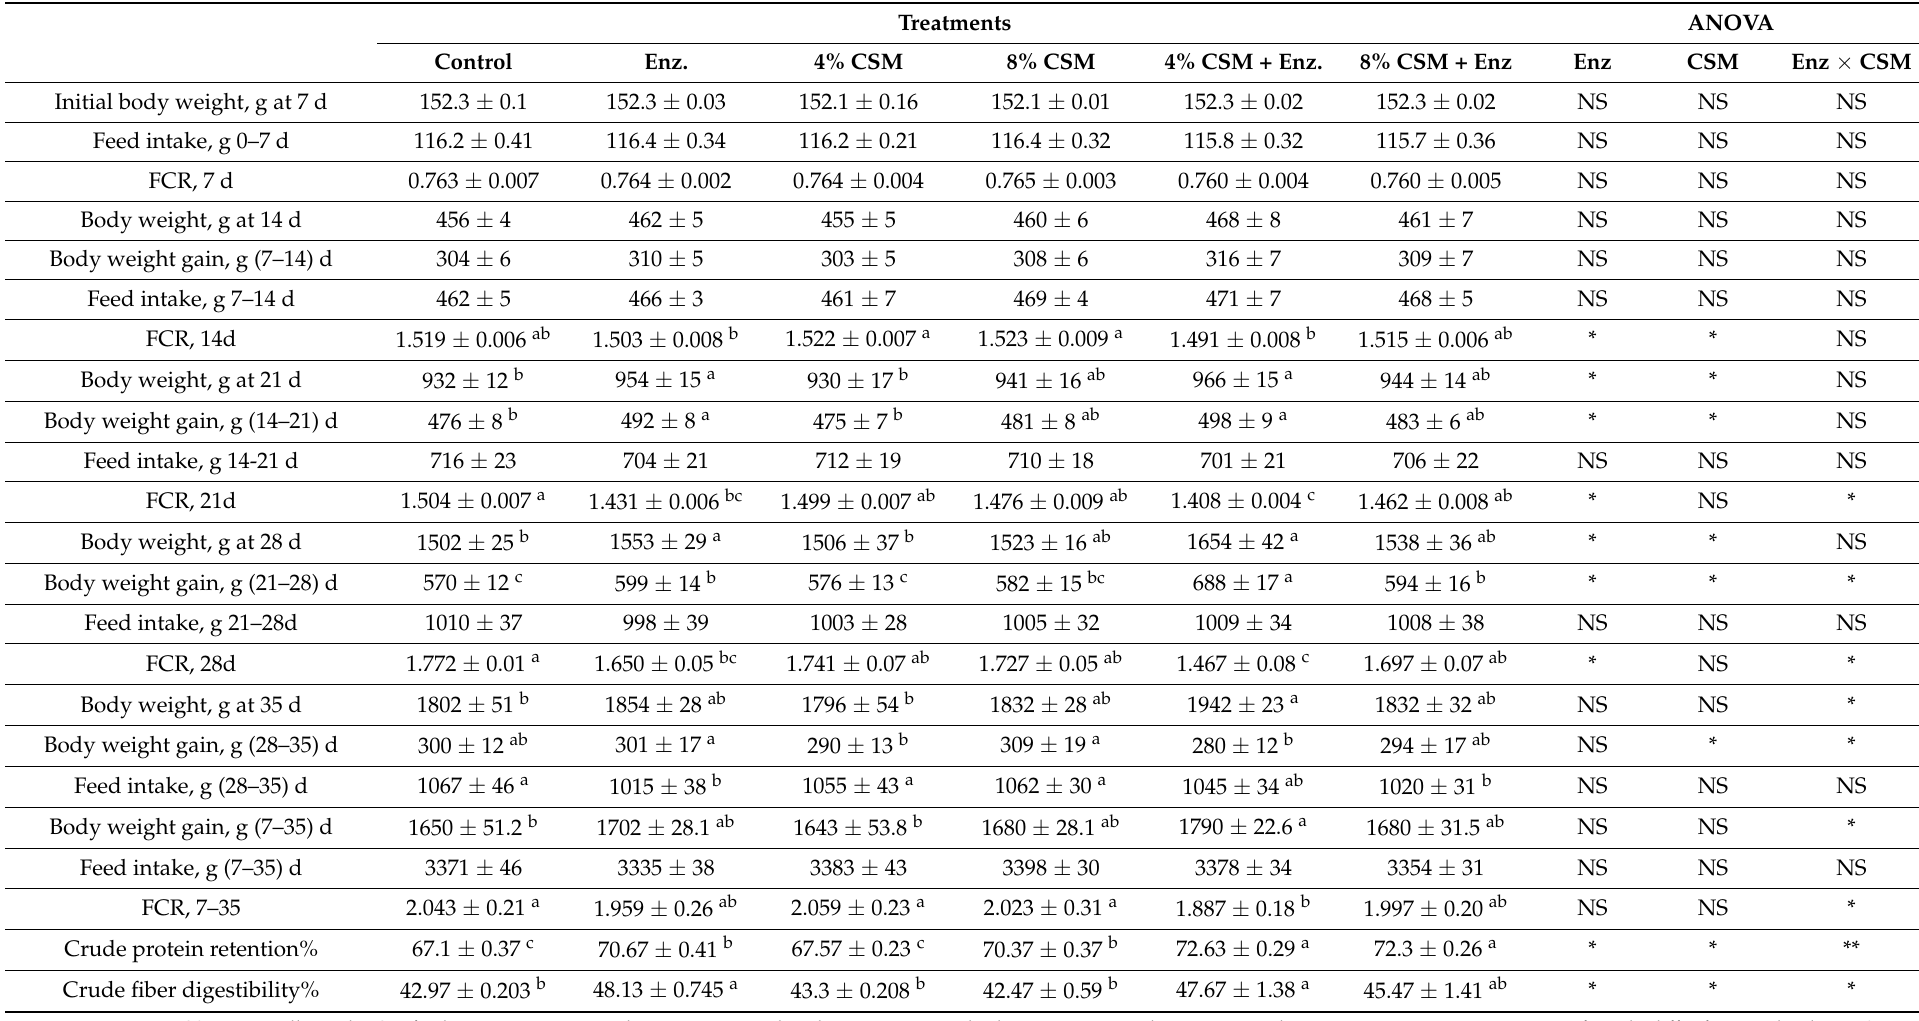
Table 4. Effects of feeding corn silk meal and/or non-starch polysaccharide (NSP) enzyme on the growth performance and nutrient digestibility. Treatments